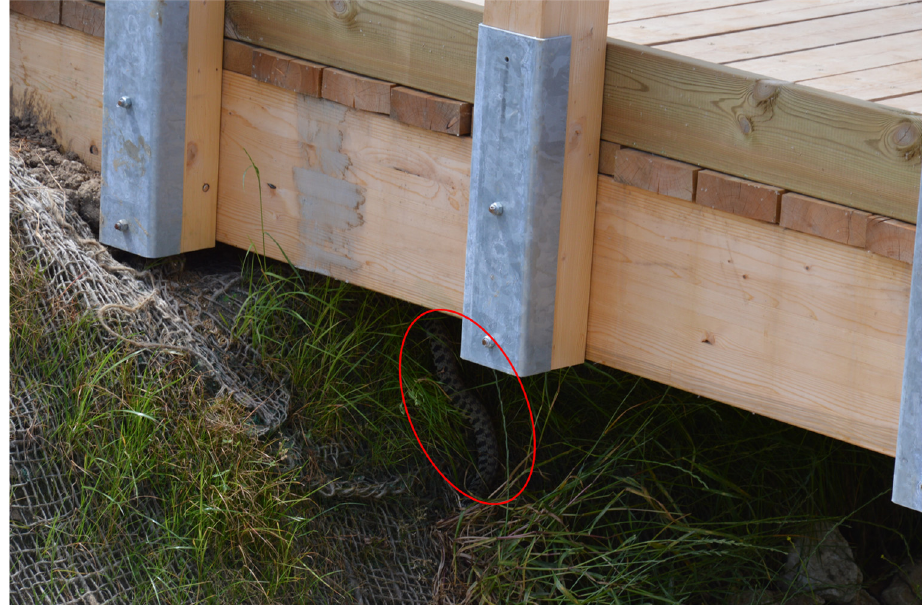
Figure 9. The red circle highlights an Natrix natrix (Linnaeus, 1758) detected during a survey in the realisation phase of the project in one bridge that was constructed to replace an old cement bridge and